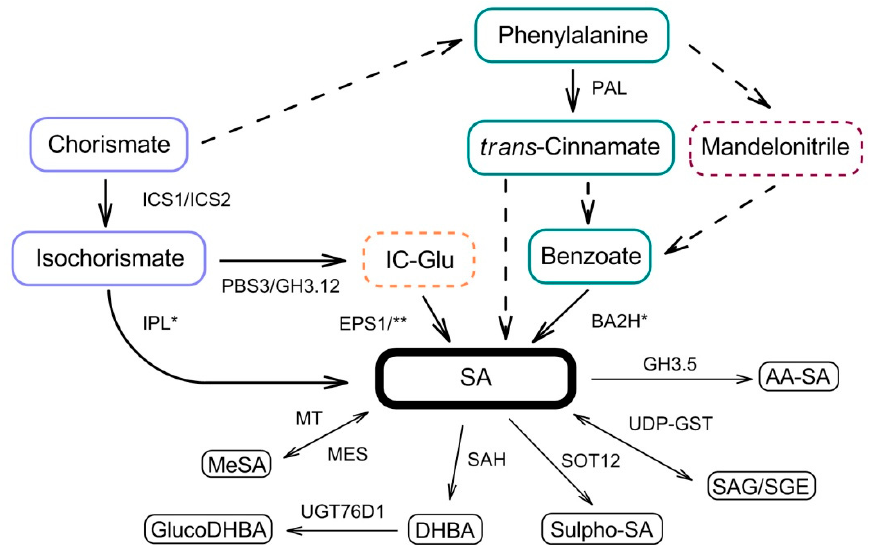
Figure 1. SA biosynthesis pathways in plants. Solid arrows represent single enzymatic steps. Dashed arrows represent multiple consecutive enzymatic steps. AA-SA, amino acid-SA conjugate; BA2H, benzoic acid 2-hydroxylase; DHBA, dihydroxybenzoic acid; EPS1, Enhanced Pseudomonas Susceptibility 1; GH3.5, Gretchen Hagen 3.5; ICS, isochorismate synthase; IC-Glu, isochorismate-9-glutamate; IPL, isochorismate pyruvate lyase; MeSA, methyl-salicylate; MES, methyl-salicylate esterase; MT, metyl transferase; PAL, phenylalanine ammonia-lyase; PBS3, avrPphB susceptible 3; SAG, salicylic acid glucoside; SAH, salicylic acid hydroxylase; SGE, salicylic acid glucose ester; SOT12, sulfotransferase 12; UDP-GST, UDP-glycosyltransferase; UGT76D1, UDP-glycosyltransferase 76D1; *, enzyme not cloned in plants; **, non-enzymatic decay.